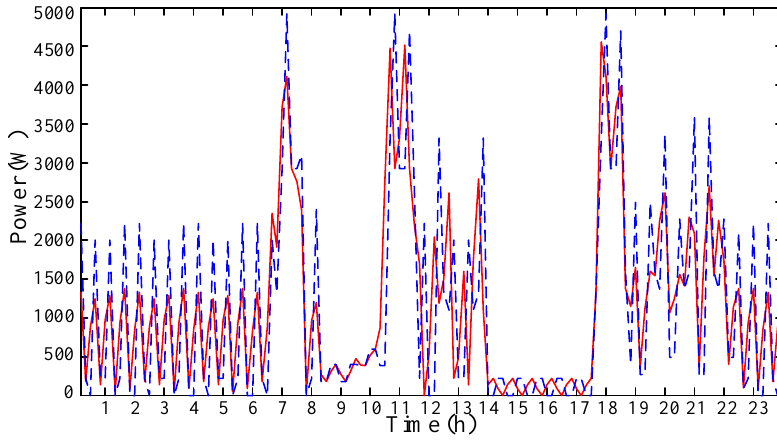
Figure 4. Expected power of a single